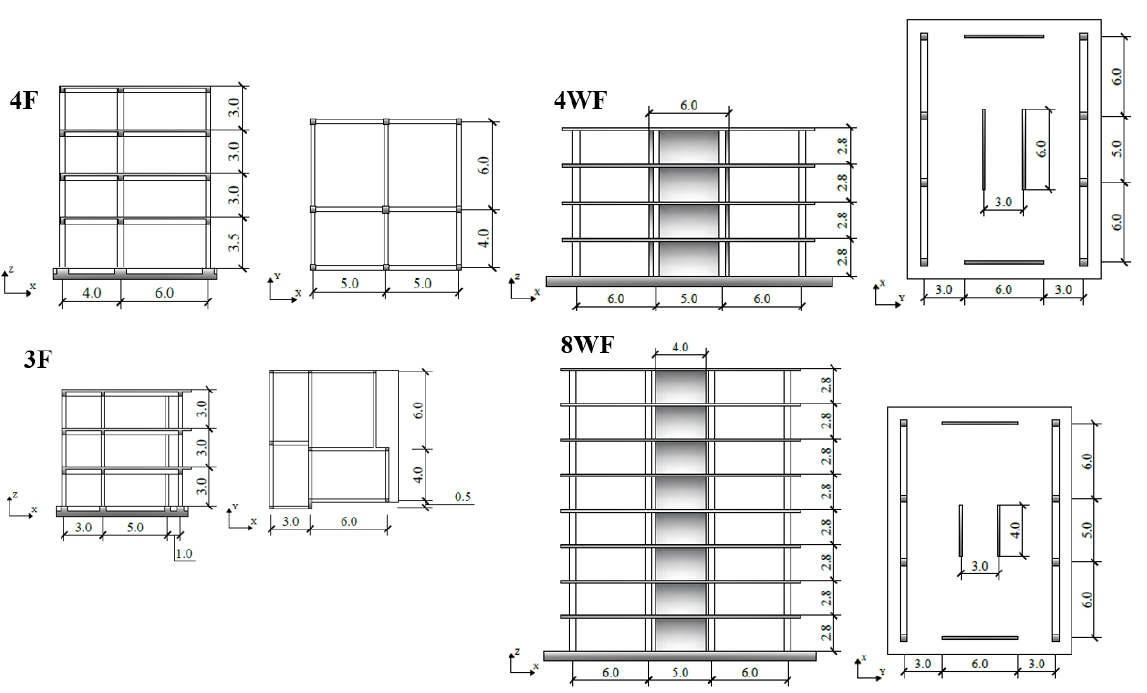
Figure 4. Schematic presentation of ( a ) MDOF model and ( b ) RDOF model of a simple wall–frame building.